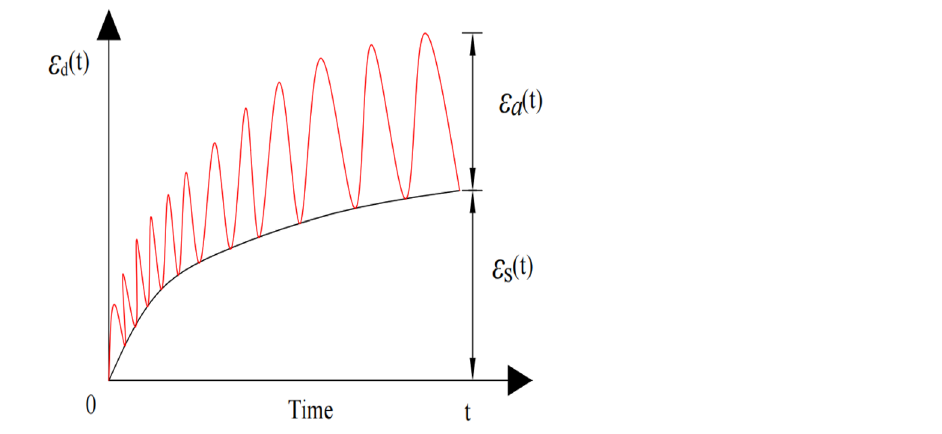
Figure 4. Total dynamic strain–time